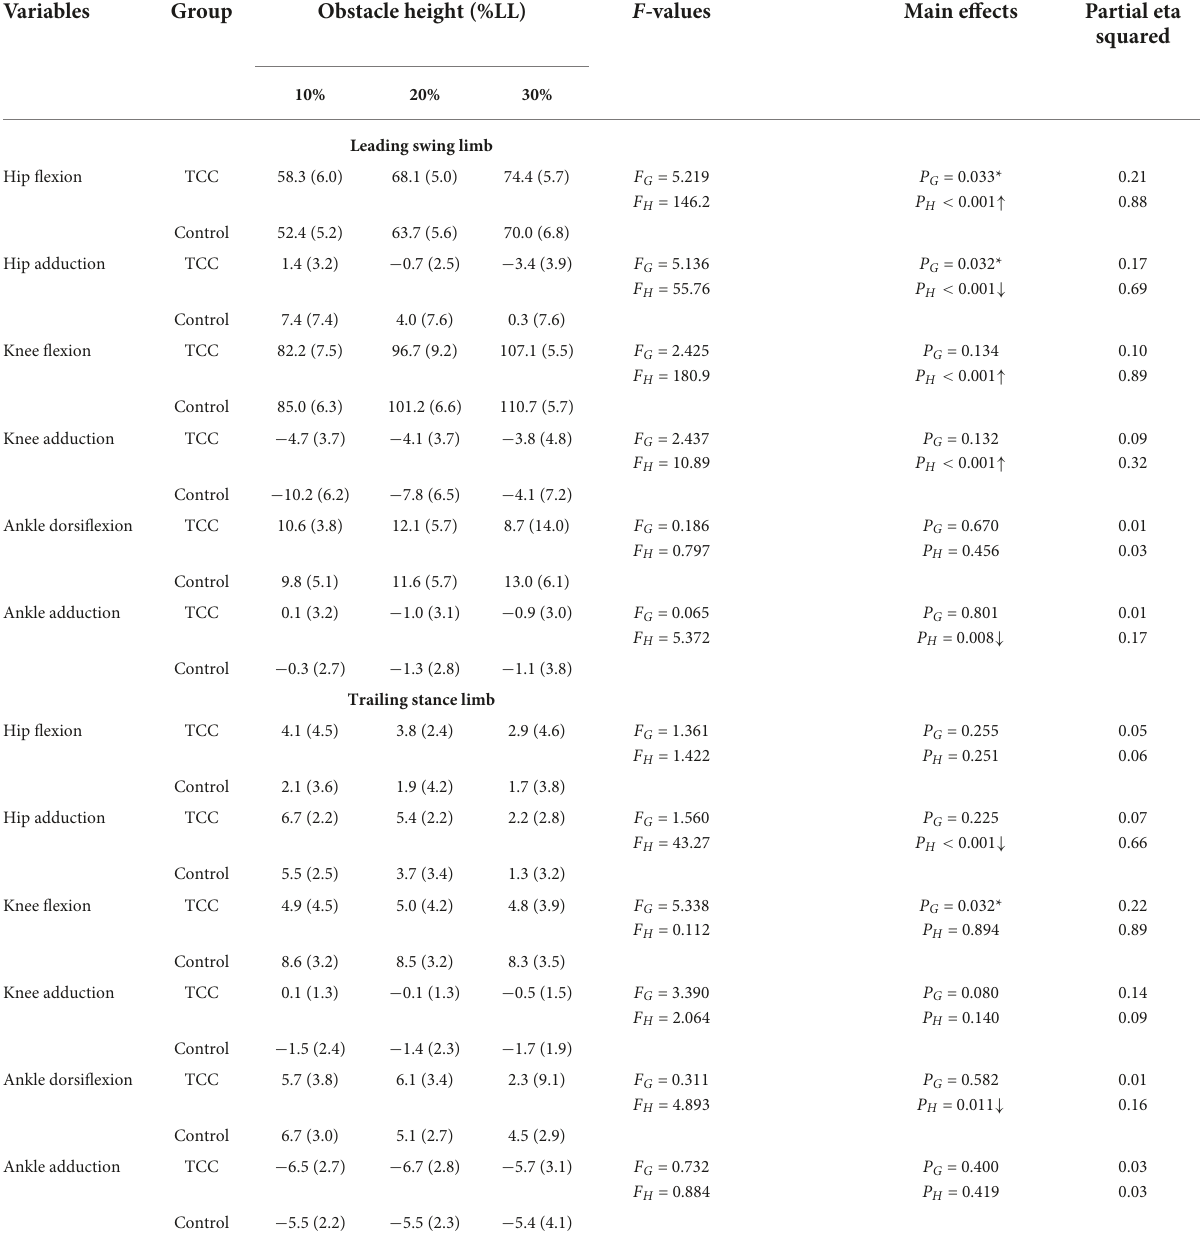
TABLE 4 Means (standard deviations) of the crossing angles of the hip, knee and ankle joints of the leading swing limb and trailing stance limb in TCC practitioners (TCC) and non-TCC controls (Control) when the leading toe was above the obstacle of heights of 10, 20, and 30% of subjects’ leg length